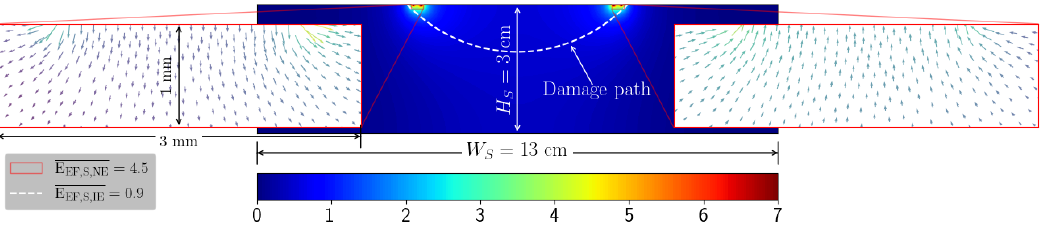
Figure 4. The dimensionless enhancement factor (color bar) of the electric field across the sample. The enhancement factor is the electric field normalized to the electric field at the electrode contacts with the rock. The left inset is an enlarged view of electric field direction at the high-voltage electrode, and the right inset is an enlarged view of that at the grounded electrode. The insets mark the near- electrode regions with average enhancement factors of E EF , S , NE = 4.5. The white-dashed arc marks the inter-electrode region with an average enhancement factor of E EF , S , IE =